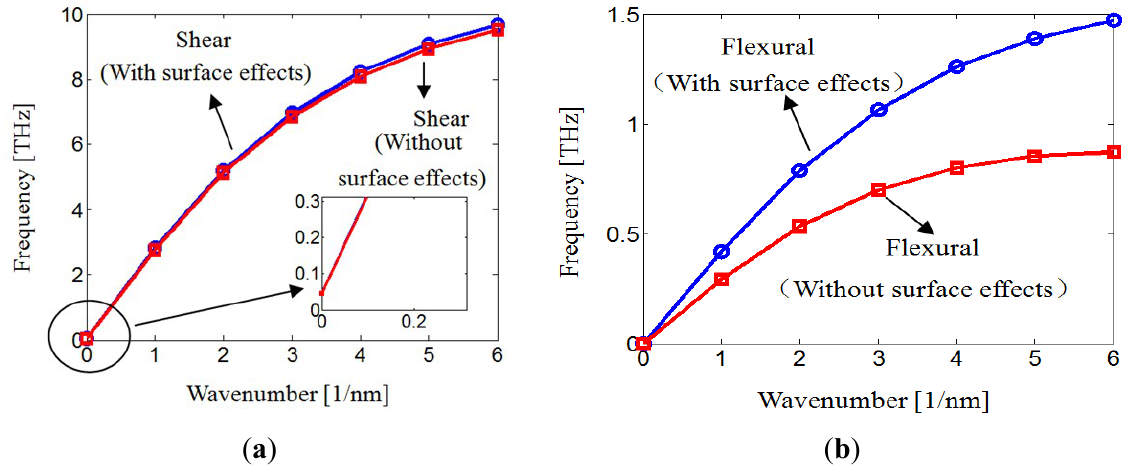
Figure 2. Wave dispersion of nanotube conveying fluid with and without surface